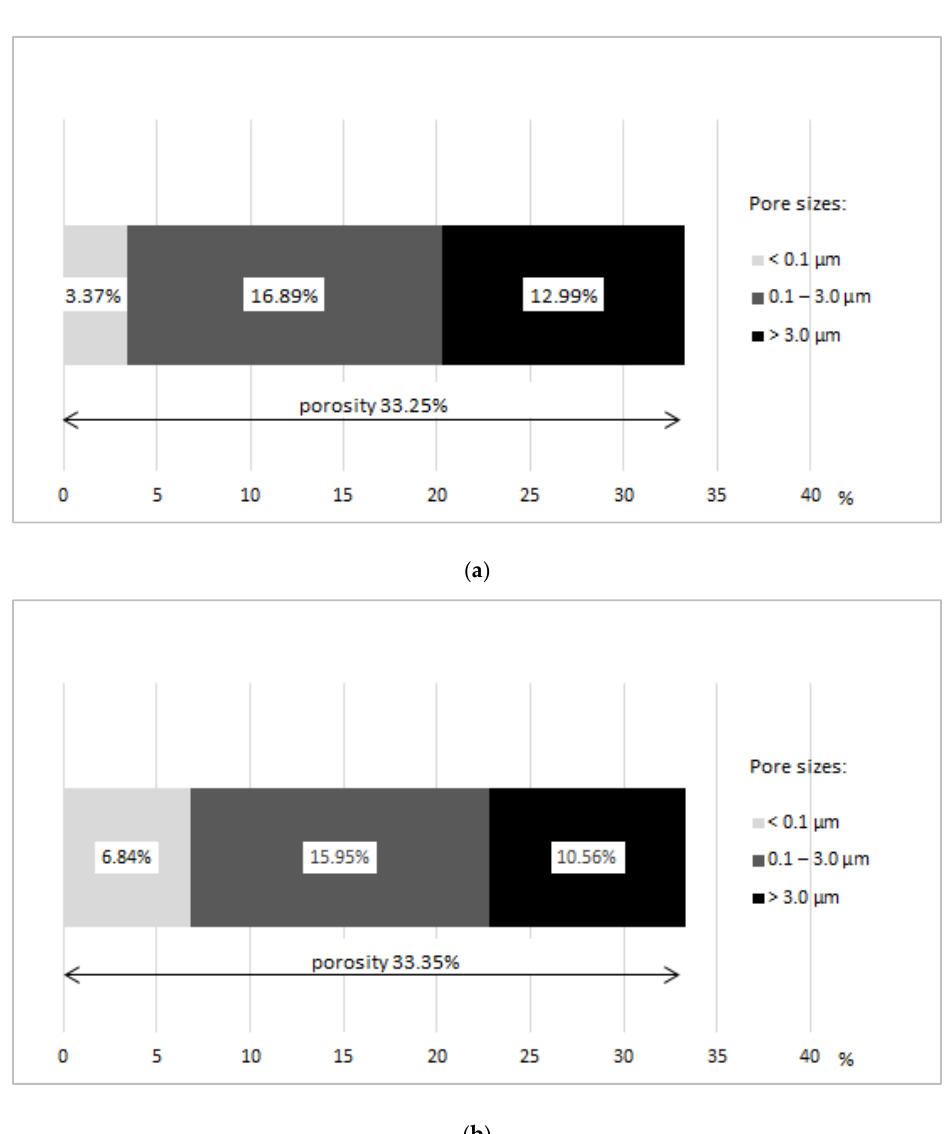
Figure 8. Typical porosity ranges: ( a ) group A samples, ( b ) group B samples.